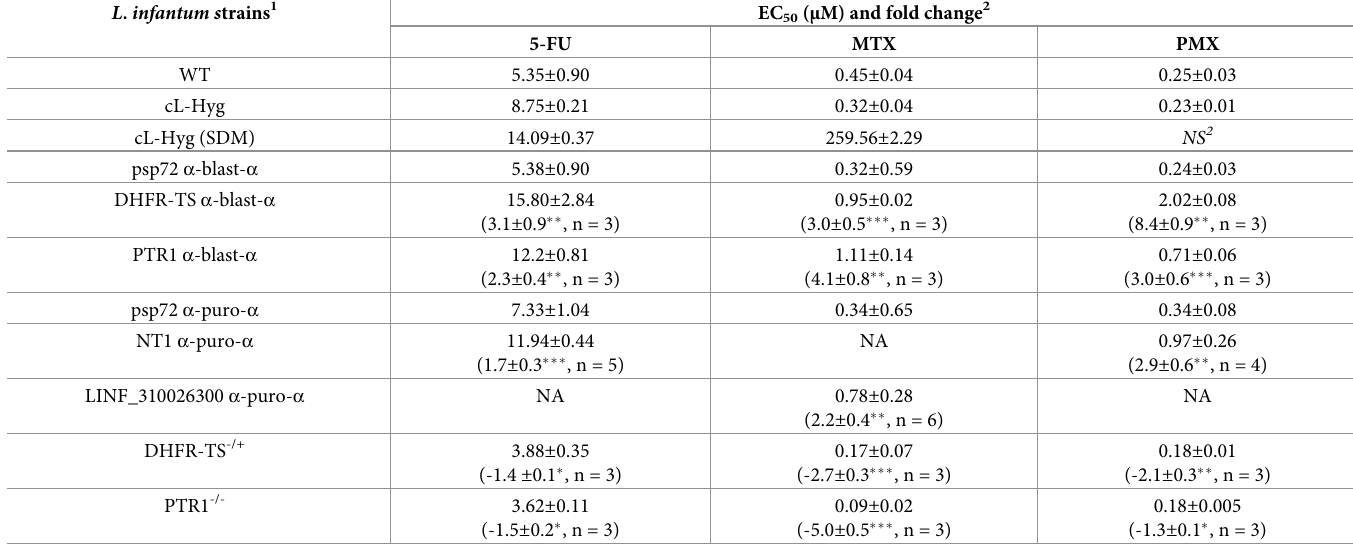
Table 1. Susceptibilities to antimetabolites of Leishmania infantum transfected with genes pinpointed by a Cos-seq screen. L . infantum s trains